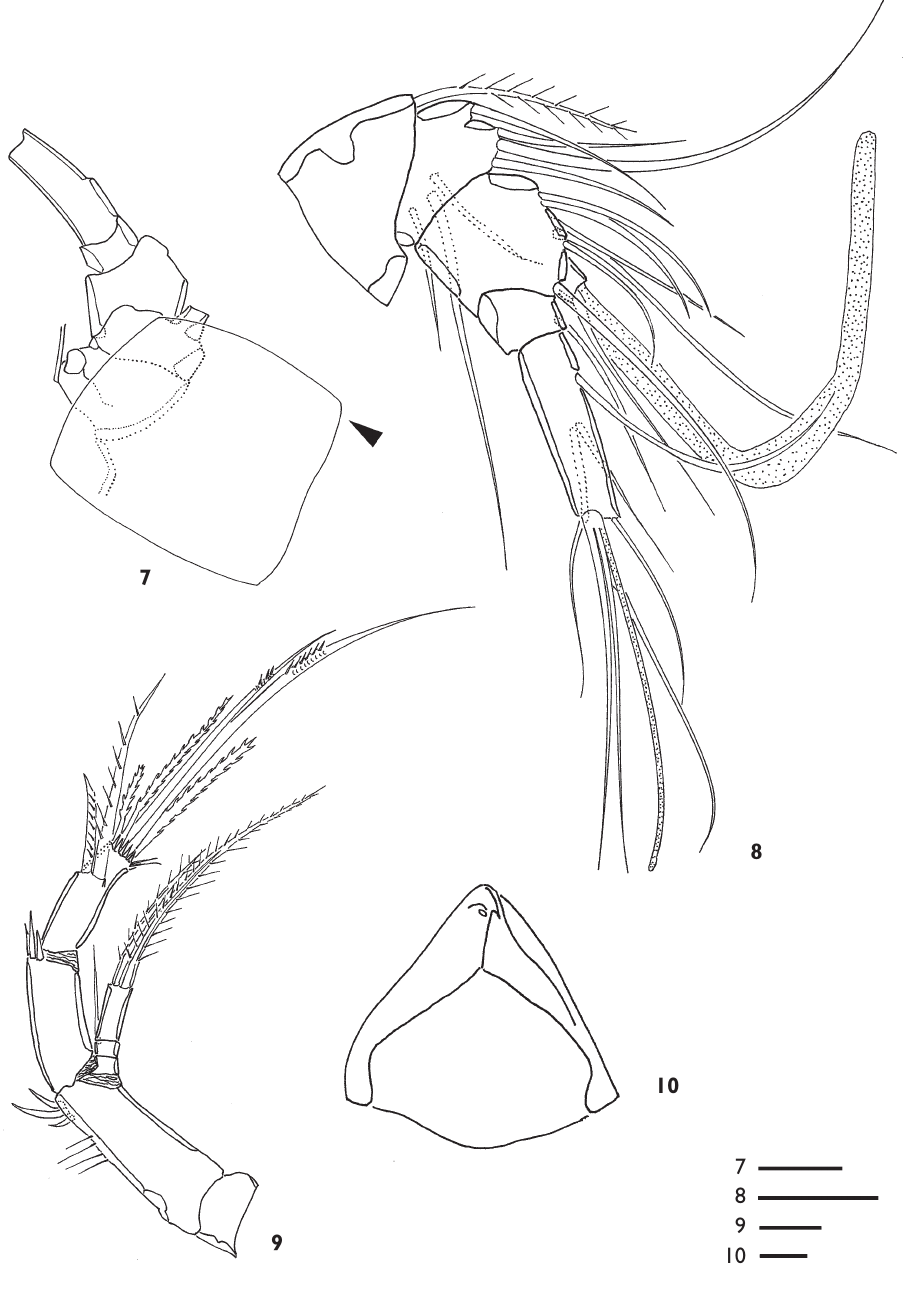
Figures 7-10. Chaulionyx paivacarvalhoi gen. et sp. n. ♀ : 7 rostrum (arrowed) and left antennule (arma- ture omitted), dorsal 8 right antennule, dorsal 9 antenna 10 labrum. Scale bars = 10